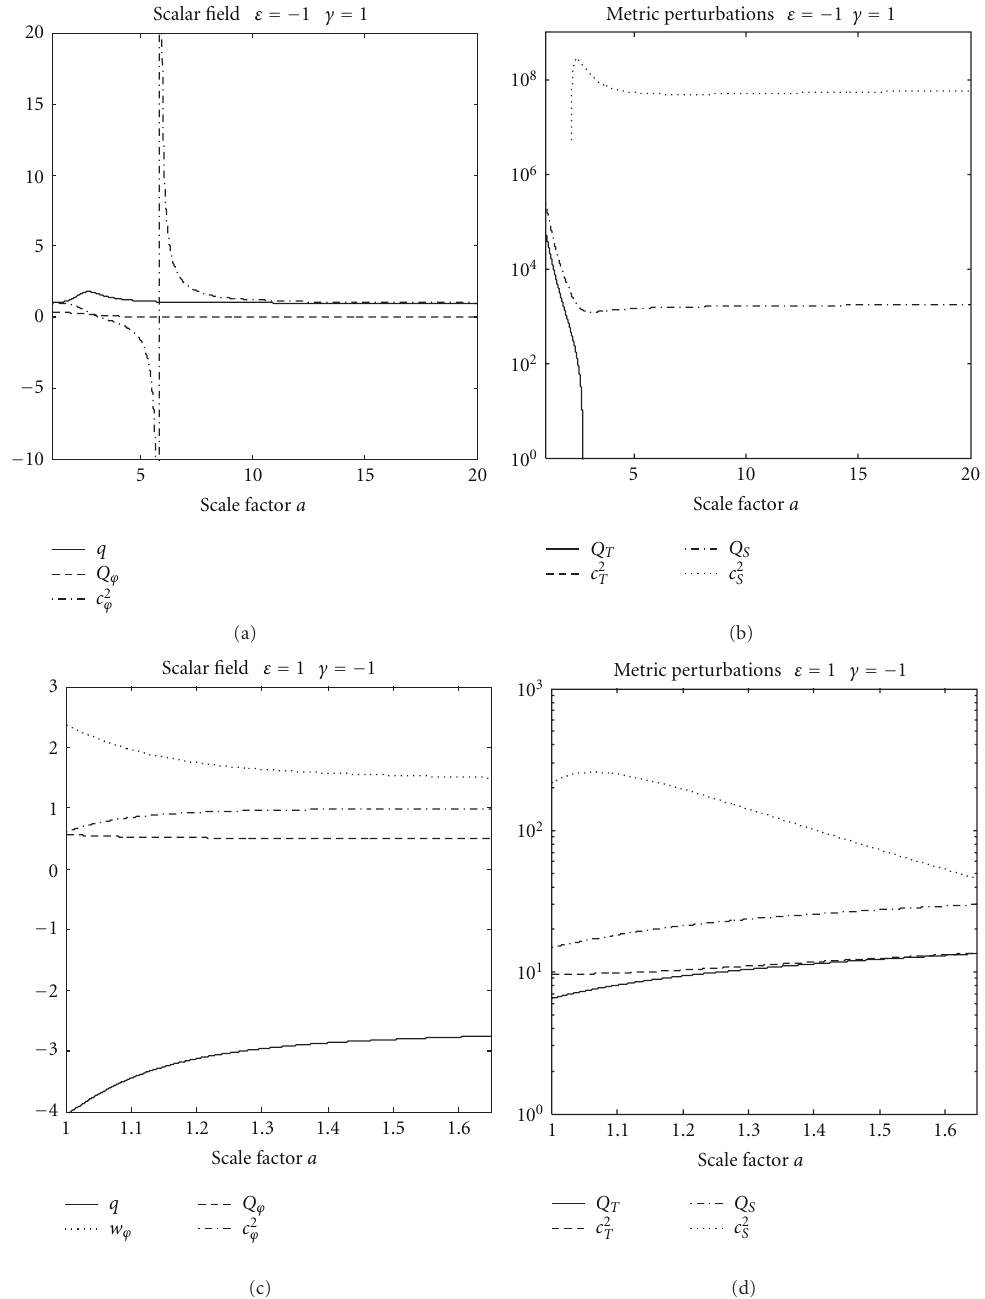
, Q S , c 2 , Q T , c 2 with the scale factor. Top: the case (cid:2) = − 1 and γ = 1 corresponds to a “double S T ϕ < 0 and there are periods for which c 2 < 0 and Q T < 0. Bottom: the case (cid:2) = 1 and γ = − 1. T s